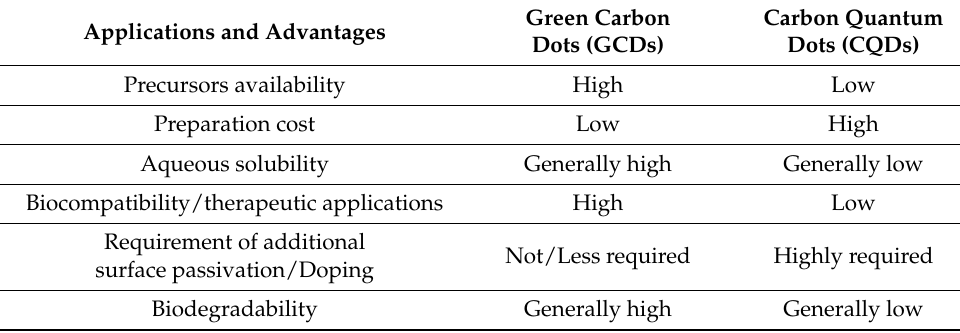
Table 1. Advantages of GCDs over